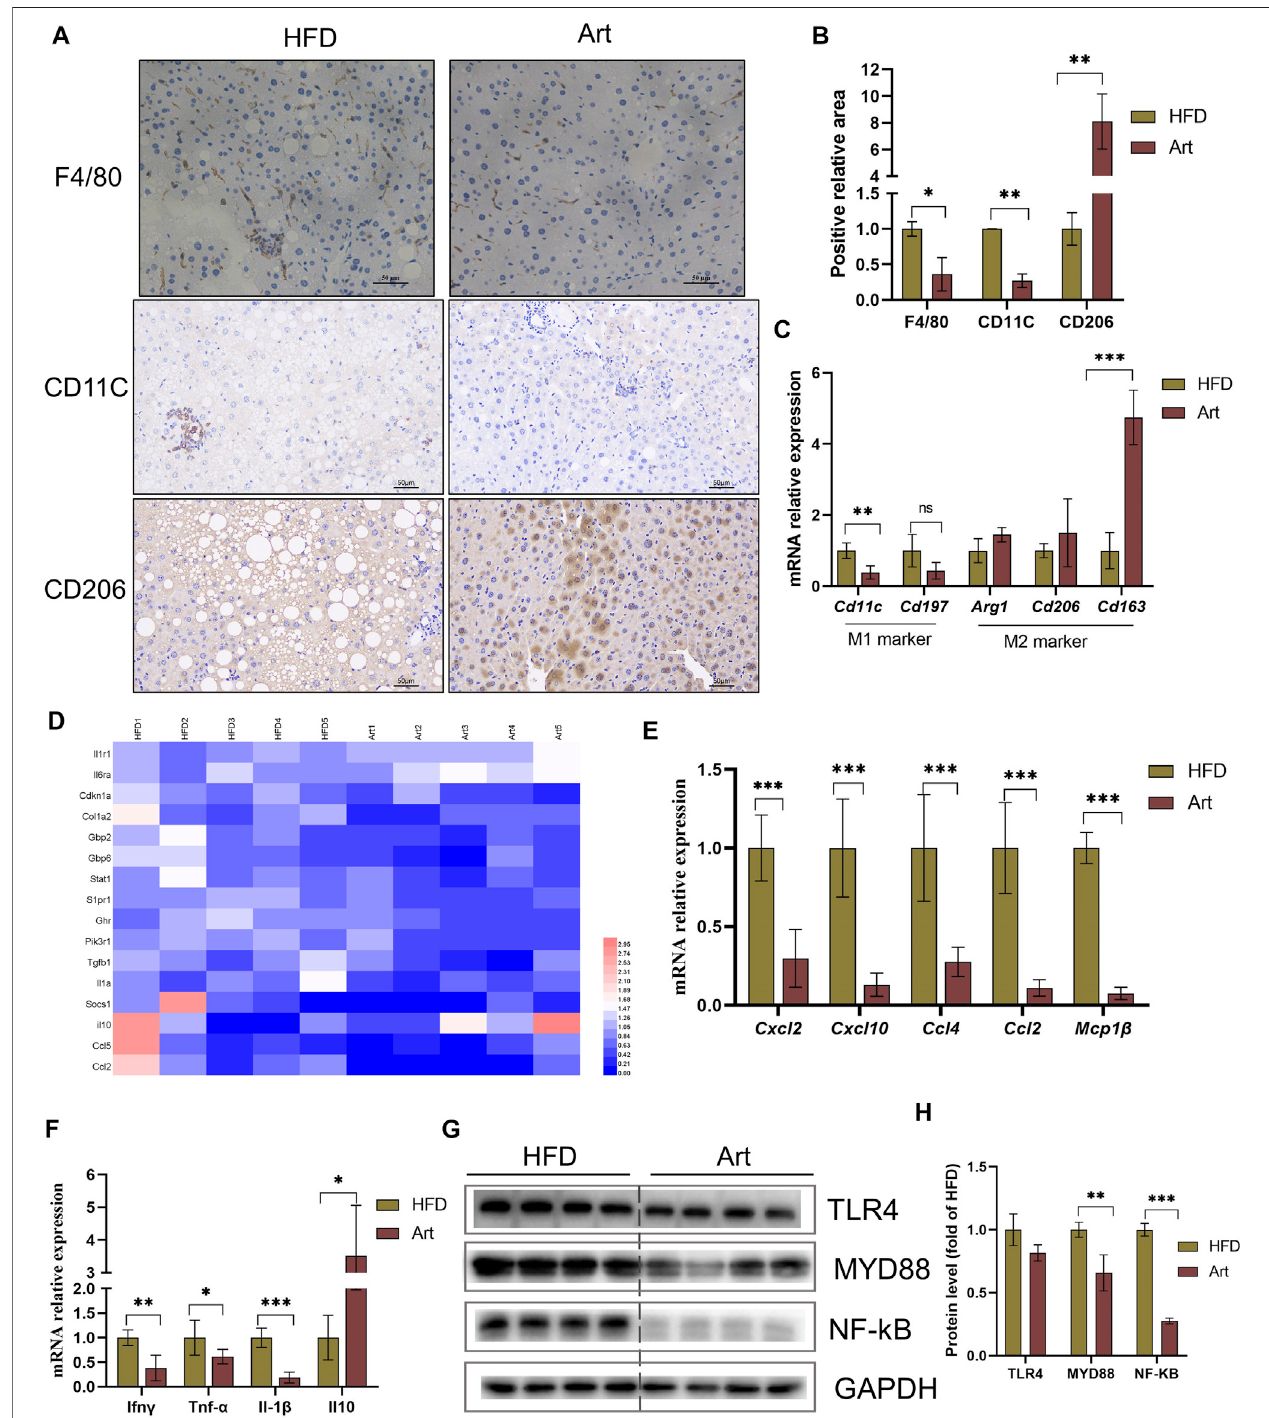
FIGURE6| ArtemetherreducedHFD-induced liverin fl ammation. (A) F4/80,CD11C,and CD206immunohistochemistry. (B) Quanti fi cation ofF4/80,CD11C,and CD206 staining positive areas ( n = 3). (C) qRT-PCR was used to detect the expression of M1-type marker genes ( Cd11 and Cd197 ) and M2-type marker genes ( Arg1 , Cd206 , and Cd163 ). (D) Heat map of liver in fl ammation – related differential genes between NASH and Art groups. (E,F) Real-time PCR analysis of chemokine-related genes (E) and in fl ammatoryfactor-relatedgenes (F) intheliver. (G,H) ProteinlevelsofTLR4,MYD88,andNF-kbintheliver.* p < 0.05,** p < 0.01,and*** p < 0.001.